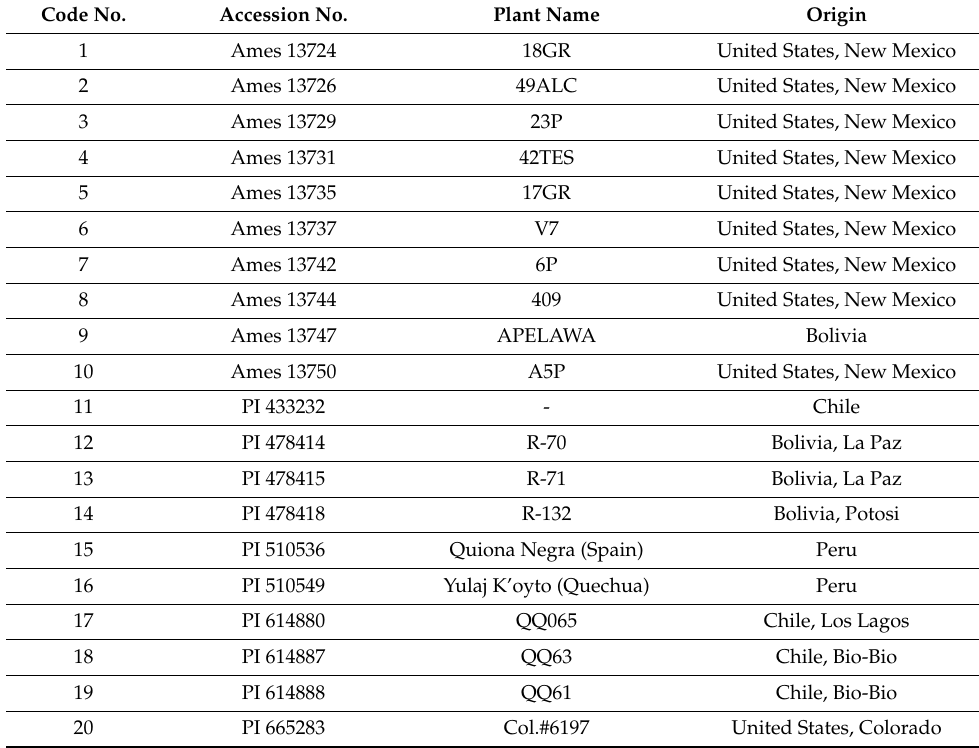
Table 1. Quinoa genotypes and their origin. Code